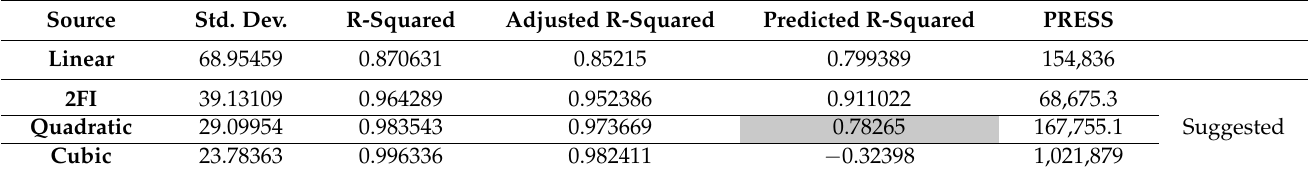
Table 1. Statistical parameters based on different regression fit models and R-factors for response time (s).